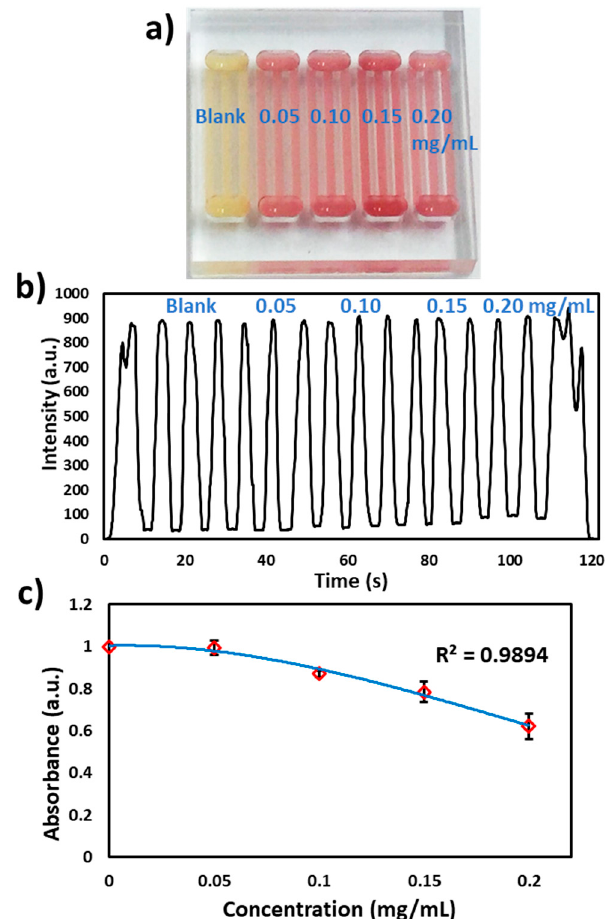
Figure 6. β‐ lactamase activity in milk. ( a ) Photograph of the microchip with loading of different concentrations of β‐ lactamase (blank, 0.05, 0.10, 0.15 and 0.20 mg/mL), ( b ) Transmitted light intensity profile of reaction of different concentrations of β‐ lactamase with nitrocefin. ( c ) Graph of the β‐ lactamase concentration vs absorbance measured via the flow cell.